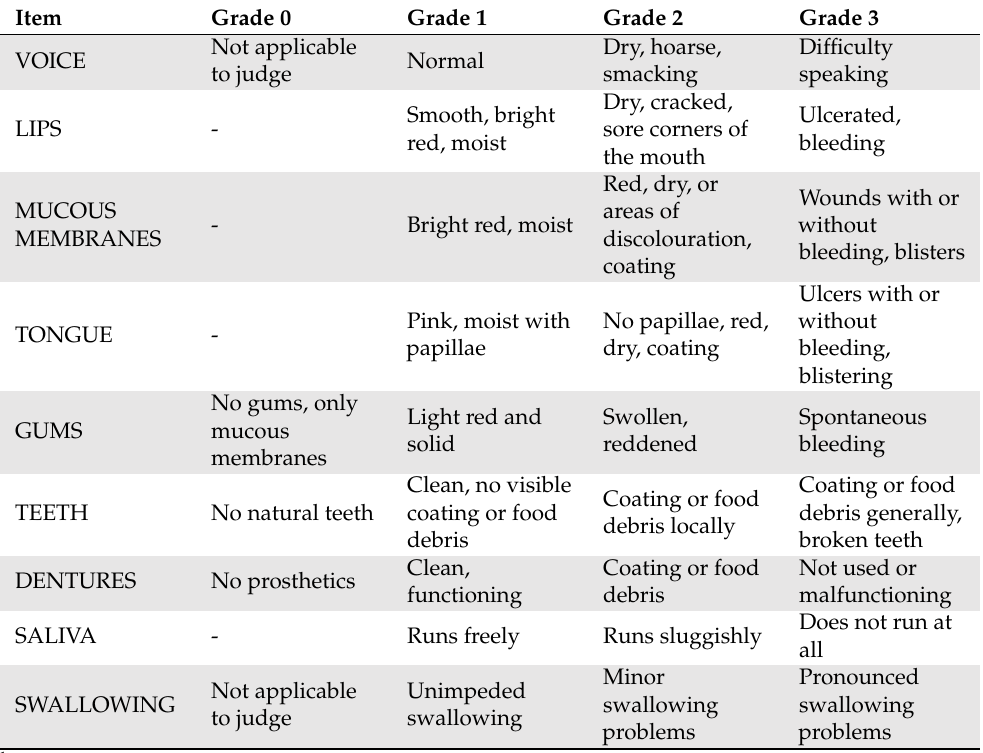
Table 1. ROAG-J in Senior Alert; the nine items and the grades 1 .